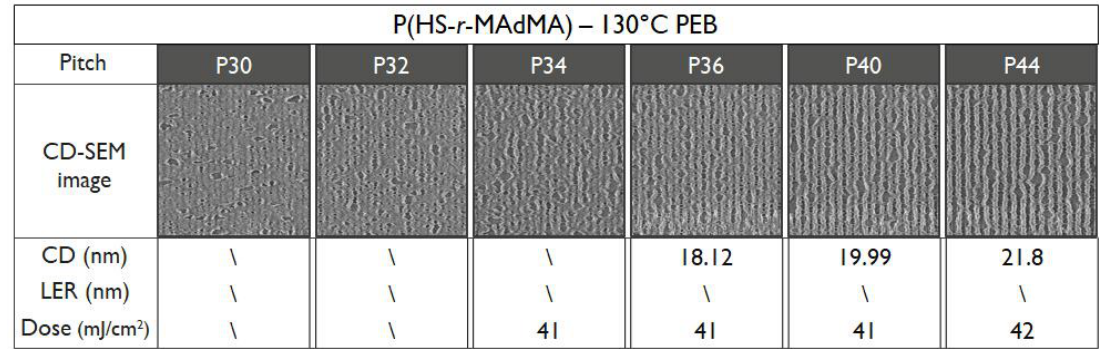
Polymers 2020 , 12 , x FOR PEER REVIEW Figure 13. Patterning performance of the P(HS- r -MAdMA) polymer-based resist at 130 °C PEB.